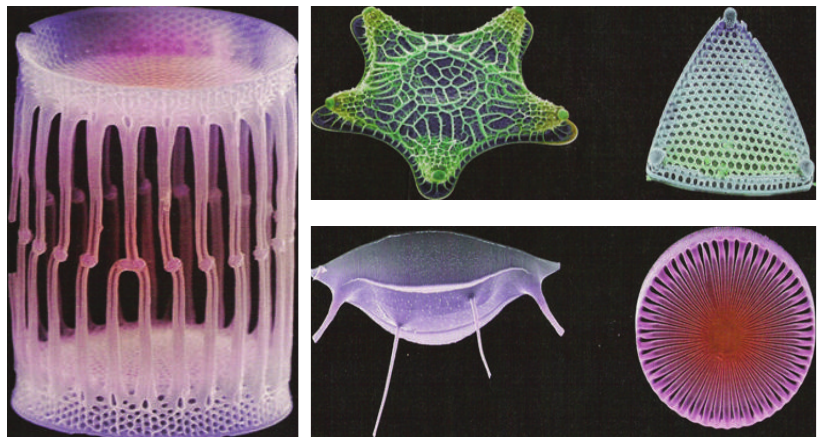
F 4: Spicules of (A, D–F) S. domuncula and (B, C) G. cydonium . (A) e skeletal tissue of S. domuncula only forms long spicules called megascleres which are either tylostyles (spicules with swelling at one end) or styles (pointed at both ends); the axial canal one spicule is broken. (B) Microscleres (mis) are composed both of megascleres (mes) and microscleres, consisting of many thin rays radiating from a globular center and with the axial canal clearly visible in cross sections (C), sometimes with the axial �lament (af) visible. (D) e tylostyle (sp) swelling has a terminal knob (k) atop a collar. (�) e axial �lament may be seen more clearly in a spicular cross section. (F) e underlying axial �lament is more clearly seen when the spicule is partially dissolved in hydrogen �uoride. Reproduced with permission from